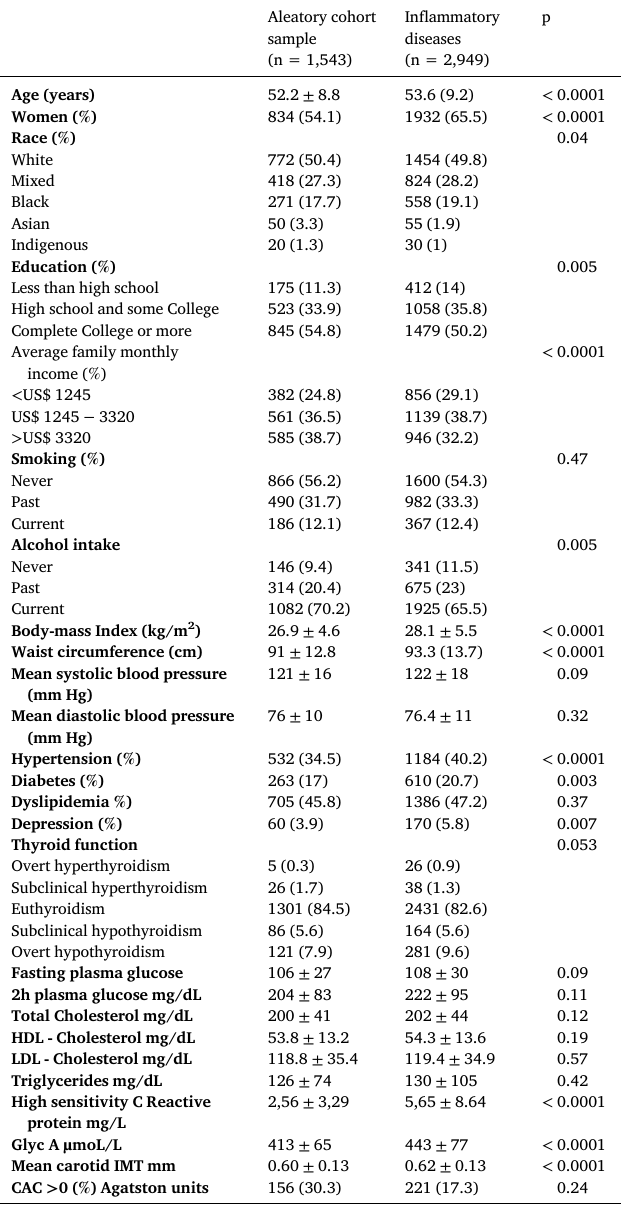
Table 1 Sociodemographic and clinical characteristics from the participants of the ELSA- Brasil study according to the risk of in fl ammatory diseases (high-risk cases and aleatory cohort sample). Aleatory cohort